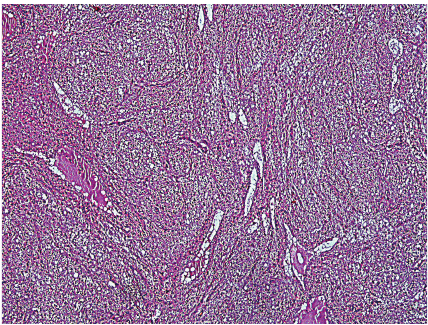
Figure 1: Tumoral lesion inside mature cystic teratoma with glial fibrillary matrix.